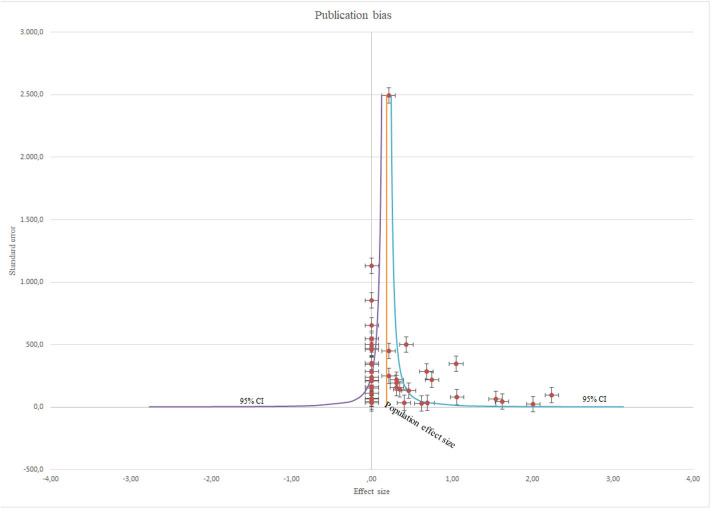
Distribution of ES.